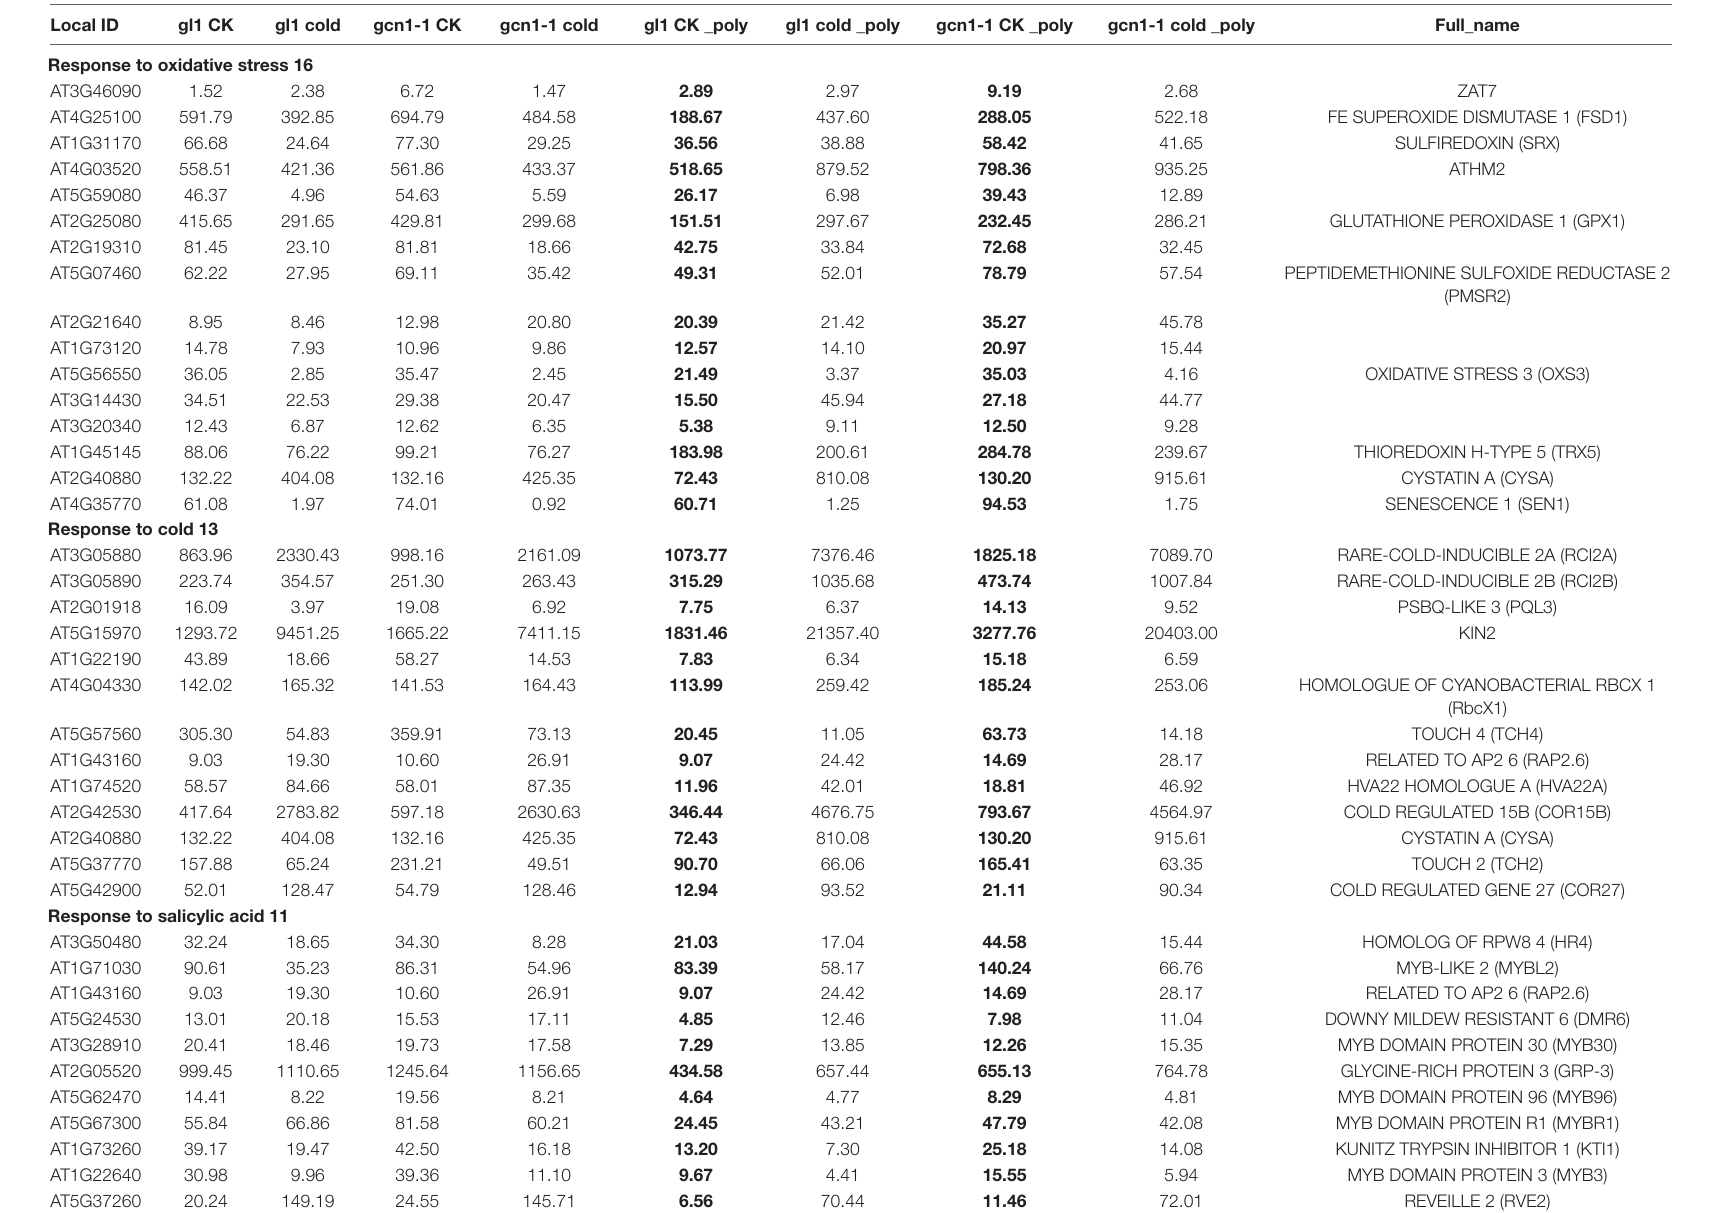
TABLE 6 | Partial classification data of up-translated genes in atgcn1-1 , compared with that in WT under normal temperature conditions. Local ID